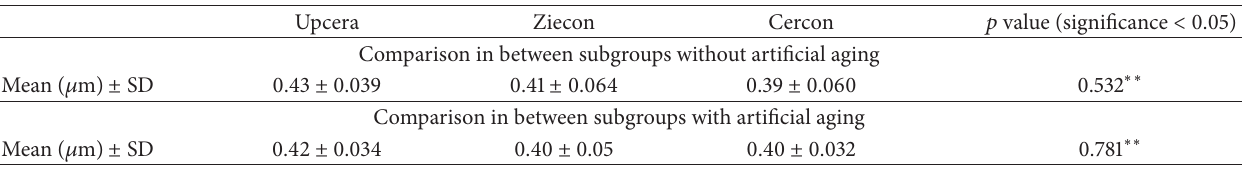
Table 8: Comparison of surface grain size ( 𝜇 m) of zirconia in all the groups showing mean, standard deviation, and significance for the samples within subgroups. Upcera Ziecon Cercon 𝑝 value (significance < 0.05) Comparison in between subgroups without artificial aging Comparison in between subgroups with artificial